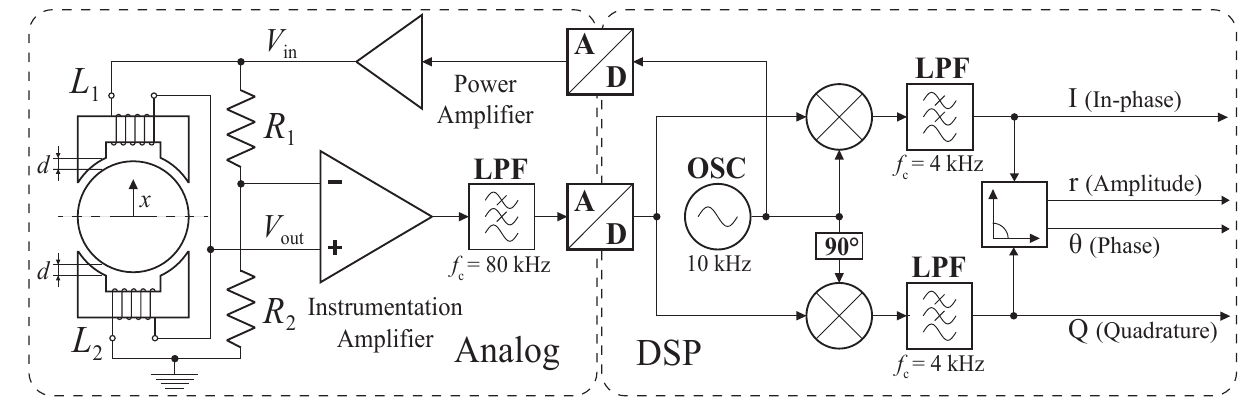
Figure 1. Displacement sensor measurement principle and signal processing chain